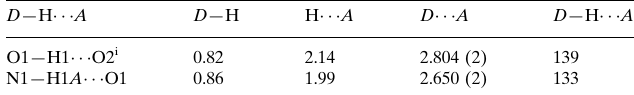
Hydrogen-bond geometry (A˚ , (cid:1)